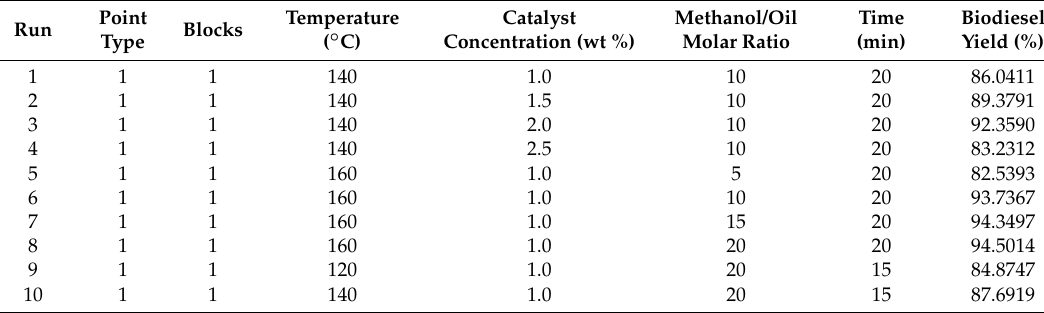
Table 3. Experiment matrix of four factors and experiment